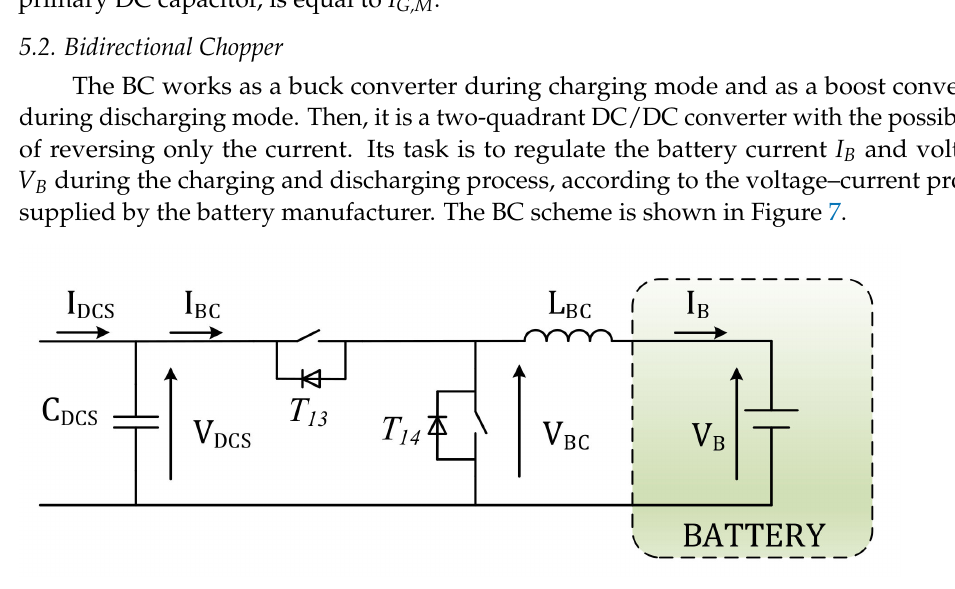
Figure 7. Battery-side of the BWV2H with BC and convention of the current according to charging